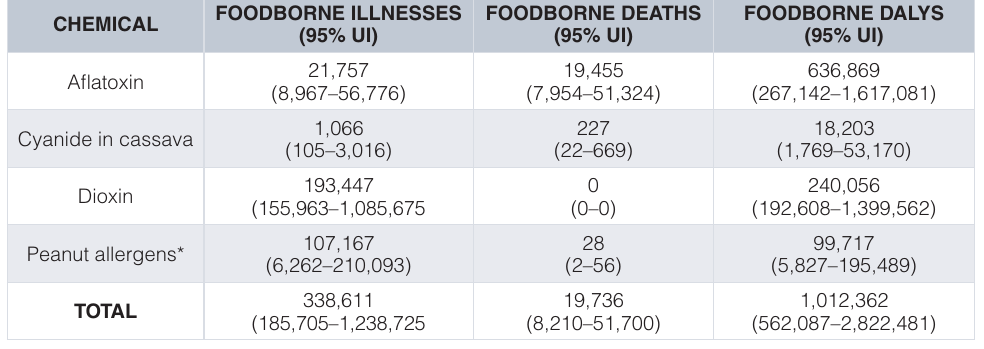
Table 2. Median rate per 100,000 foodborne illnesses, deaths, and DALYs by WHO region, with 95% UIs.